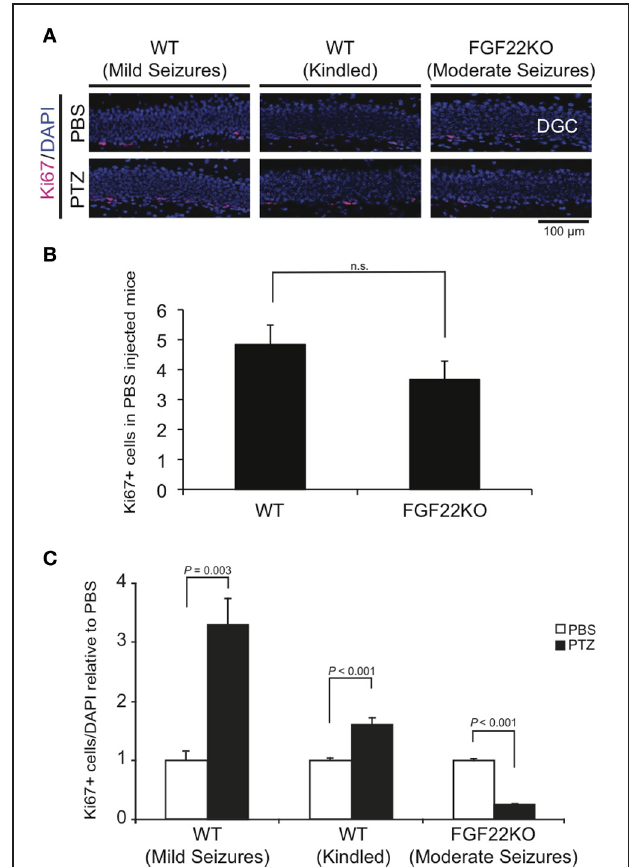
FIGURE 2 | The number of proliferating cells in the DG increases in WT mice but decreases in FGF22KO mice upon PTZ injections. Region-matched sagittal hippocampal sections were prepared from PBS- and PTZ-injected WT and FGF22KO mice (3 groups of mice as shown in Figure 1 ) and stained for Ki67, a marker for proliferating cells. (A) Ki67 positive cells (pink) with DAPI (blue) in the DG of PBS- or PTZ-injected WT and FGF22KO mice. (B) Quantification of the numbers of Ki67-positive cells in the DGC layer per section in PBS-injected WT and FGF22KO mice (n.s. = not significant). (C) Quantification of the percentages of Ki67-positive cells in DGCs. Data are normalized against corresponding PBS controls. The percentage of Ki67-positive cells was significantly increased in WT mice with mild and kindled seizures, but was decreased in FGF22KO mice with moderate seizures upon PTZ-injections. Bars are mean ± s.e.m. Data are from 4–6 sections from 3–10 mice (see Figure 1B ) per each condition. Student’s t -test P -values are